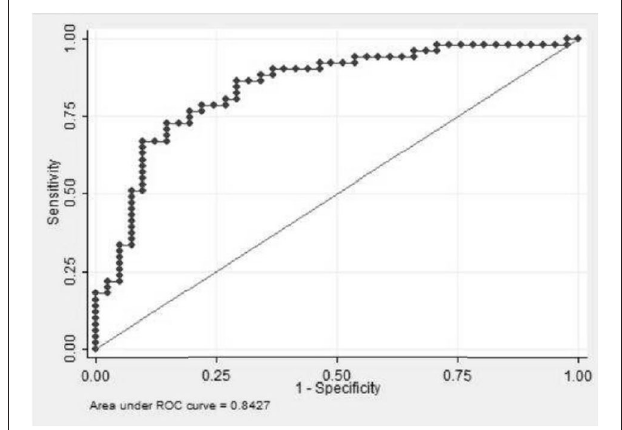
FIGURE 2 | Receiver operating characteristic curve of the final